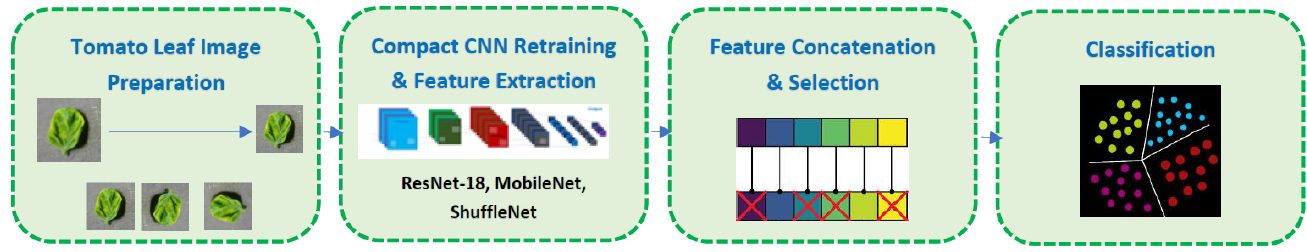
Figure 2. The workflow of the proposed pipeline for tomato leaf image